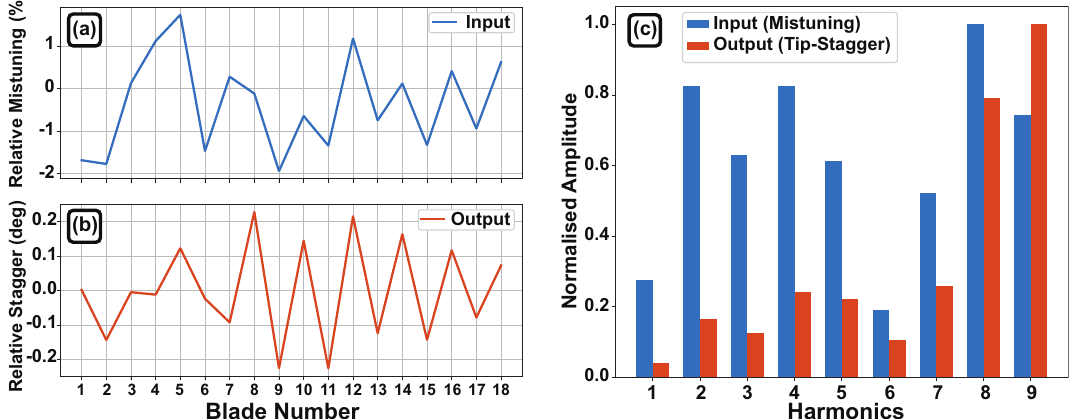
Figure 11. Effect of mistuning on running geometry. (a) Initial mistuning pattern. (b) Resulting tip stagger pattern. (c) Fourier decomposition of the patterns. A mistuned system (frequency mistuning on mode 1) could results in alternating tip stagger from a perfectly symmetrical initial